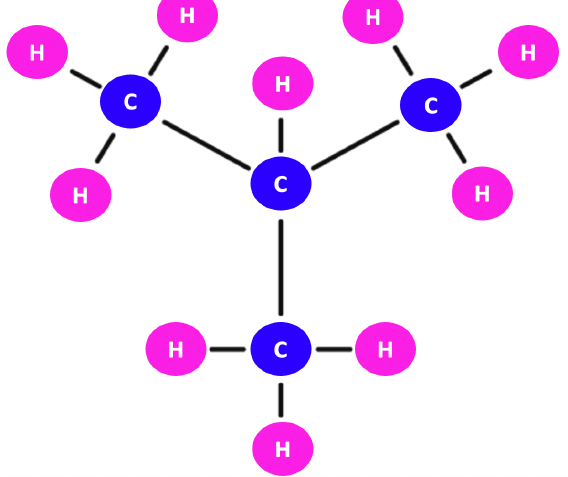
Figure 6. Chemical bond of an isobutane compound C 4 H 10 .